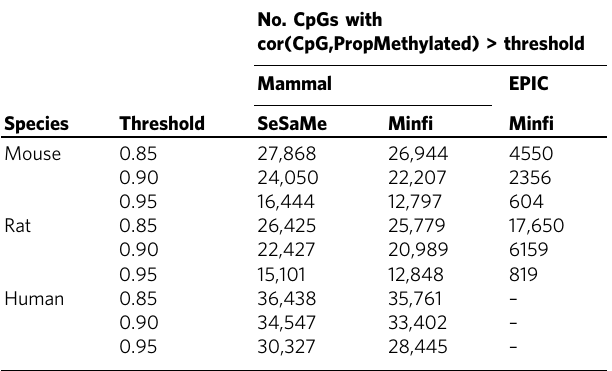
We evaluated the mammalian methylation array with two different software methods for normalization: SeSaMe and Min fi (noob normalization). The EPIC array data were only normalized with the noob normalization method in Min fi . As indicated in the fi rst column, the DNA samples came from three species: mouse ( n = 20 mammalian arrays; n = 15 EPIC arrays), rat ( n = 15 mammalian arrays; n = 10 EPIC arrays), and human ( n = 10 mammalian arrays). For each species, the arti fi cial chromosomes exhibited on average 0%, 25%, 50%, 75%, and 100% methylation at each CpG location. Thus, the variable ProportionMethylated (with ordinal values 0, 0.25, 0.5, 0.75, 1) can be considered as a benchmark/gold standard. The table reports the number of CpGs on the array for which the Pearson correlation with the ProportionMethylation was greater than the correlation threshold (second column) based on SeSaMe (third column) and Min fi (fourth column) for the mammalian methylation array and Min fi for the EPIC array ( fi fth column). All CpGs on the respective array were considered, i.e., 37,942 CpGs for the mammalian array and 866k CpGs on the EPIC array. The table does not report results for EPIC combined with the Min fi /noob normalization in humans because the underlying sample size ( n = 3) was too low ( “ − ” denotes not